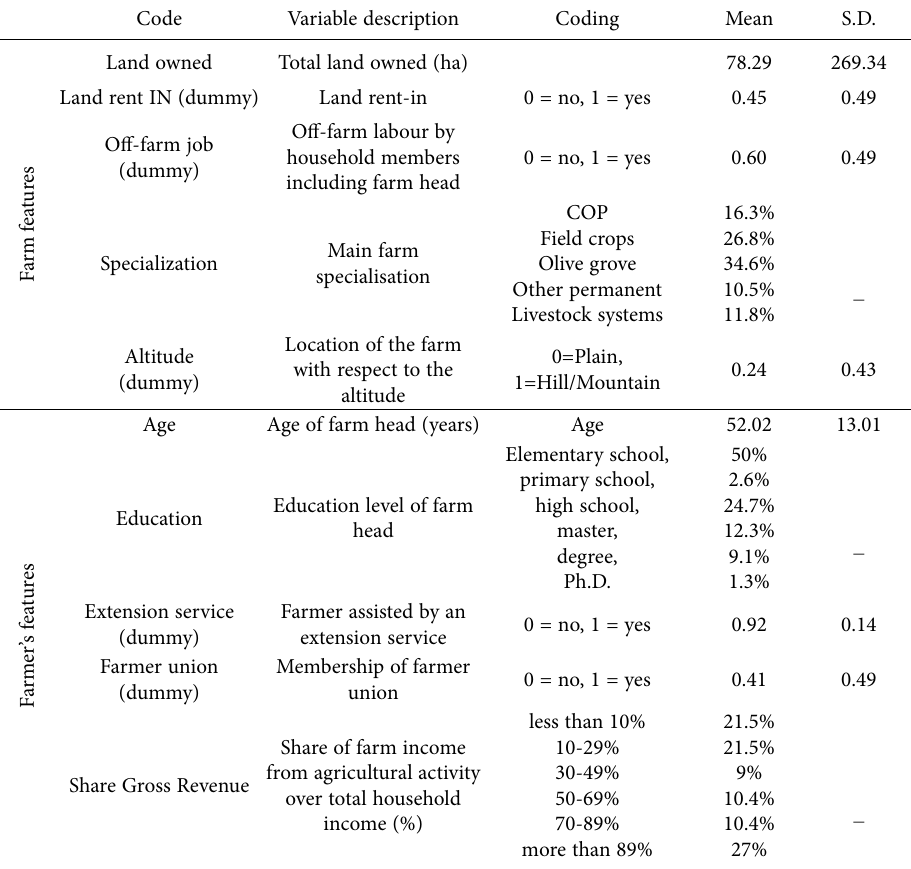
Table 2. List of variables used as